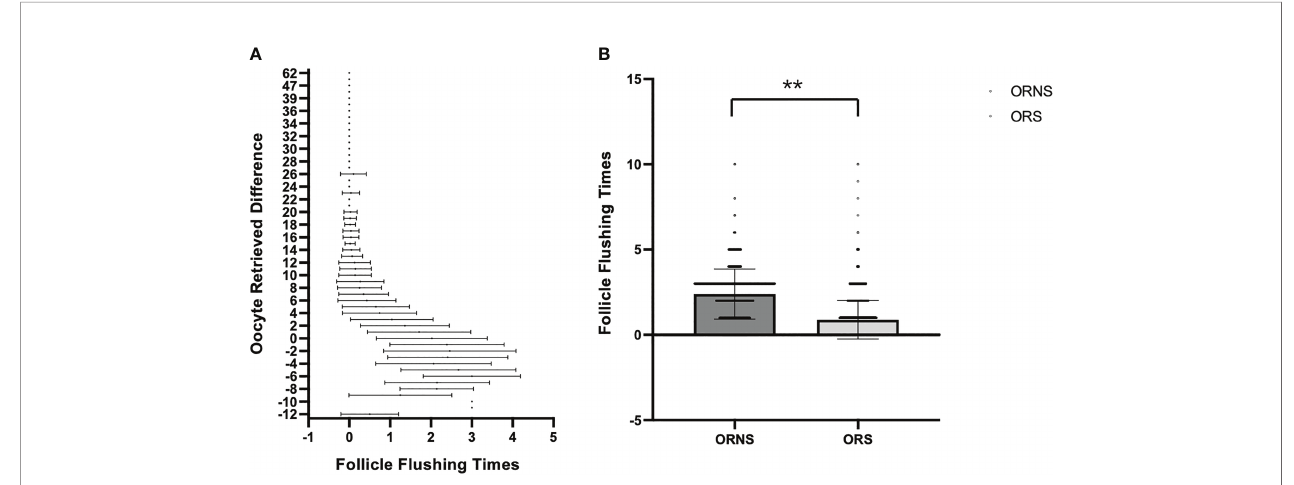
FIGURE 3 | Relationship between follicular fl ushing and difference in oocytes obtained. (A) Relationship between follicular fl ushing times and difference in oocytes obtained. (B) Follicular fl ushing difference between the ORNS and ORS groups (** P <